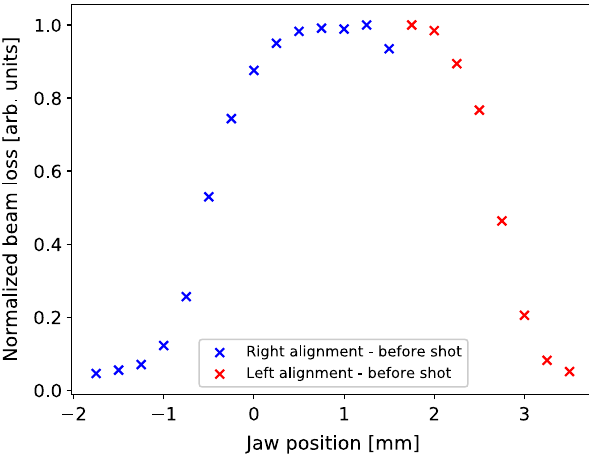
FIG. 16. The horizontal and vertical beam sizes measured with the BTV-BPKG during each of the high-intensity pulses in the experiment.